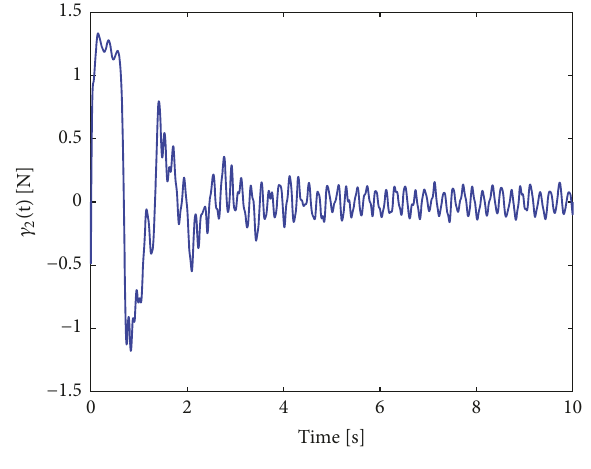
Figure 9: Control input torque 𝛾 2 (𝑡) .